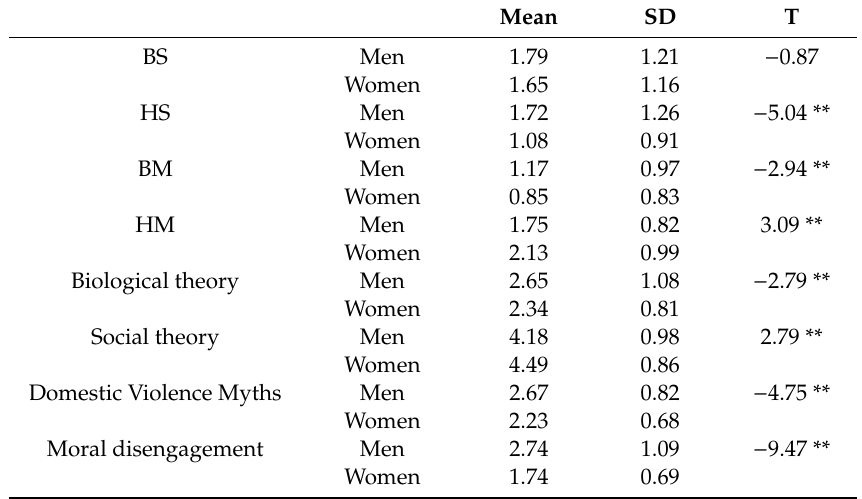
Table 1. Gender di ff erences on the study variables: means, standard deviations, and T-test